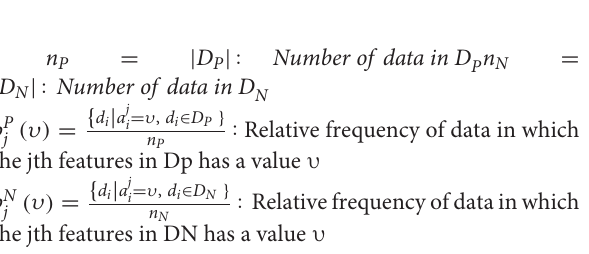
FIGURE 7 | The naive Bayesian nomogram for predicting the depressive disorders of female older adults living alone in South Korea.